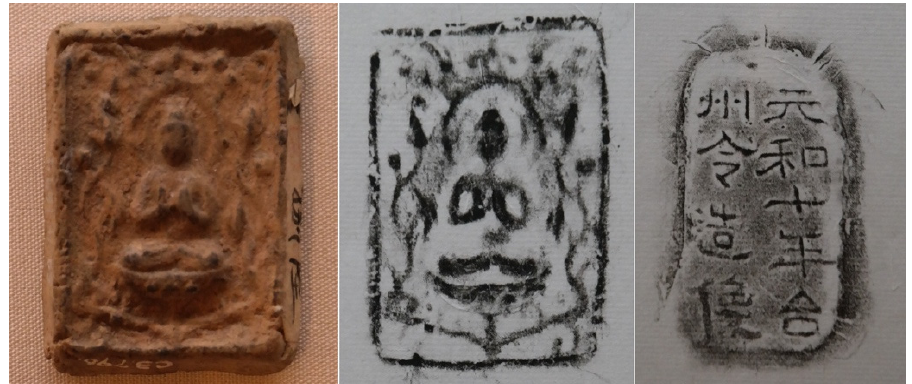
Figure 14. Clay Buddha ( left ), front rubbing ( middle ), and back rubbing ( right ) . Tang Dynasty, 815, Beijing Capital Museum, China [©Photograph by Lim, 2017].